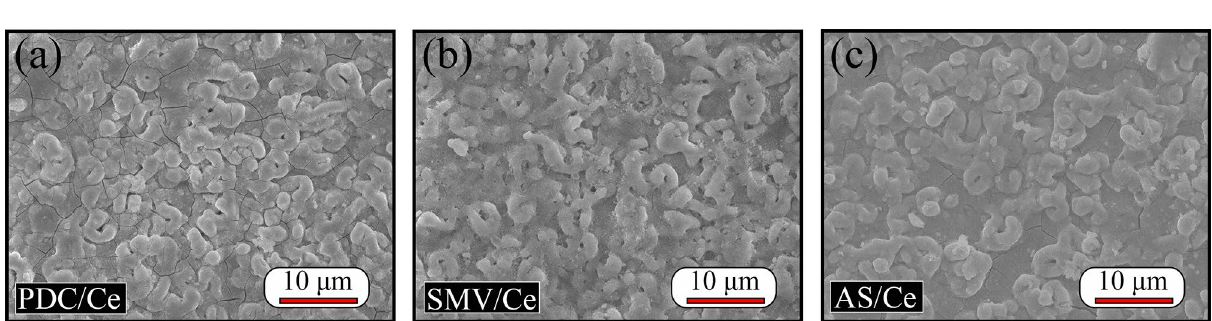
Figure 6. SEM surface morphologies of ( a ) PDC/Ce, ( b ) SMV/Ce and ( c ) AS/Ce